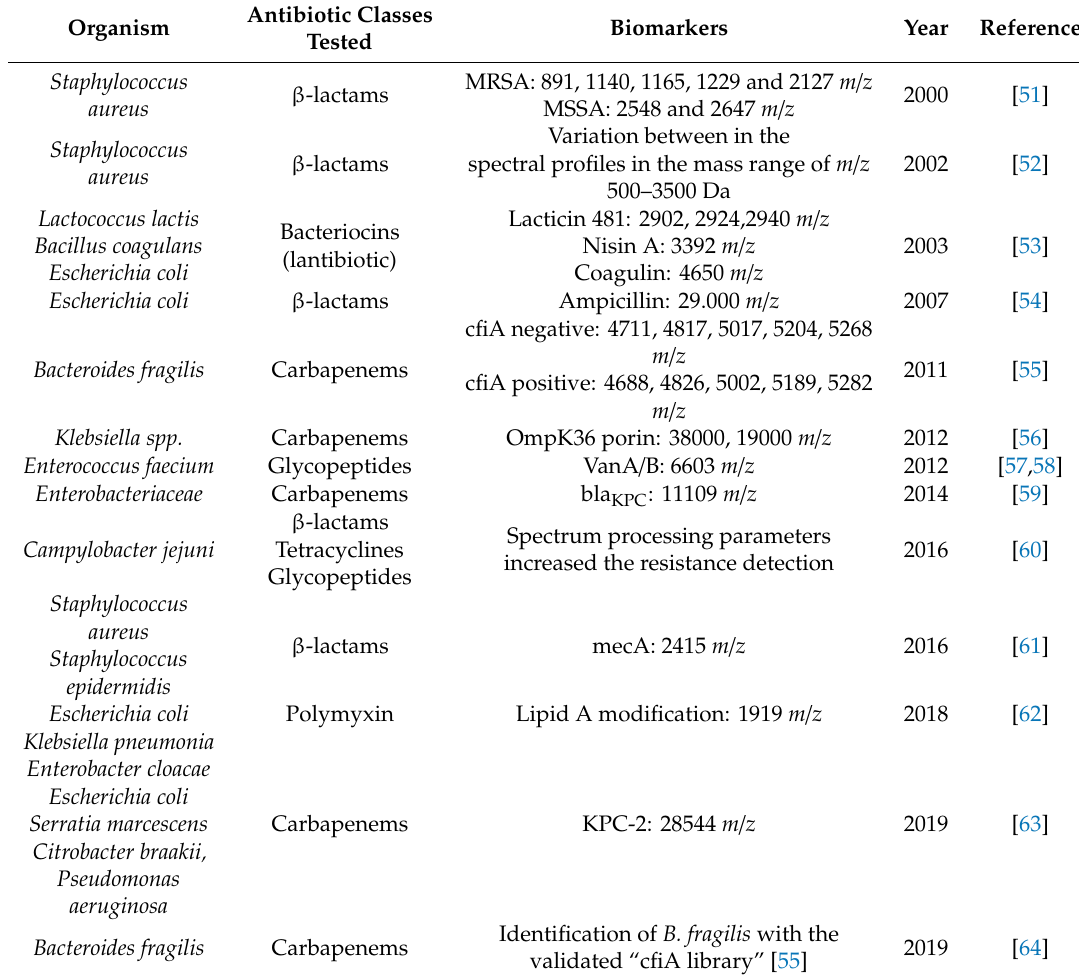
Table 1. Specific whole-cell MALDI-TOF MS spectra patterns literature for identification of antimicrobial resistance in enteric